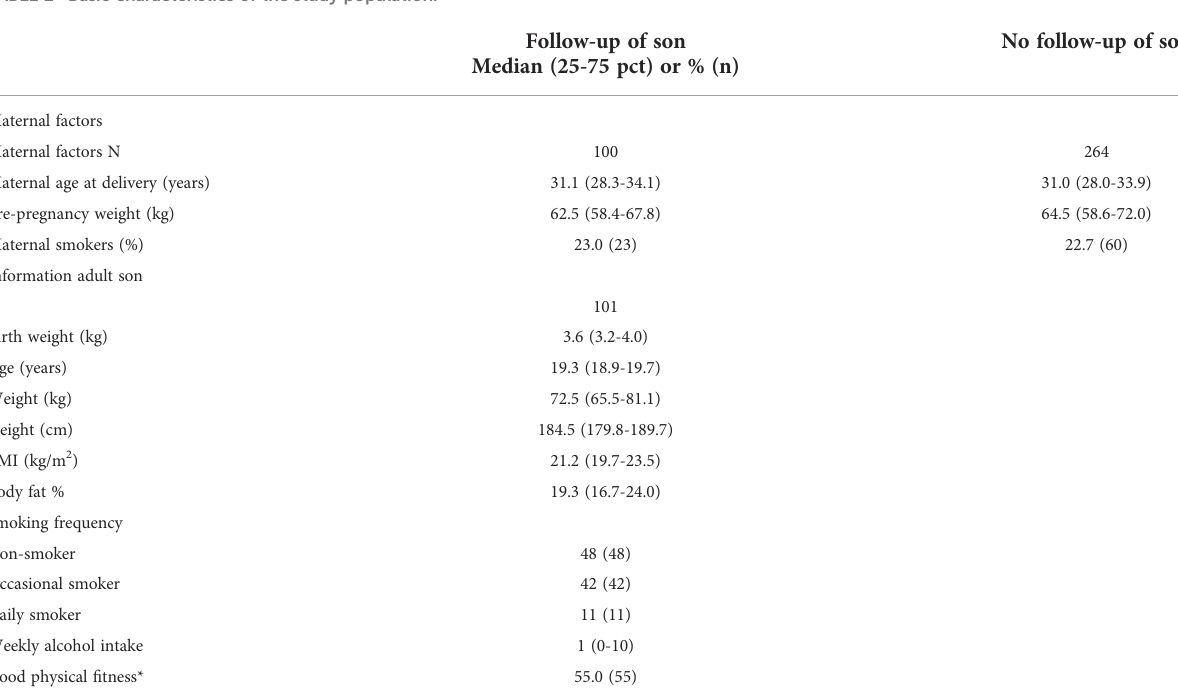
and T3: 6% (-6%,19%) compared to T1) (Figure 4; Supplementary Tables 4 – 6). Also, a positive association between BP-3 exposure and LH levels was seen (T2: 21% (-2%,49%), T3: 18% (-4%,45%) compared to T1). Finally, a tendency of higher INSL3 levels with higher tertile of BP-3 was seen (p-trend = 0.04). For 4-HBP a tendency was seen of higher exposure levels being associated to